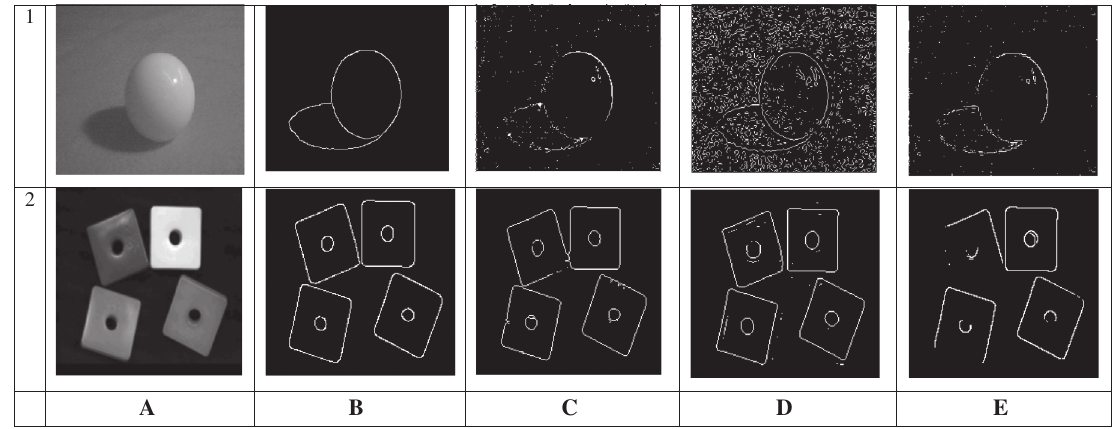
Figure 8. Further Experimental Results for Various